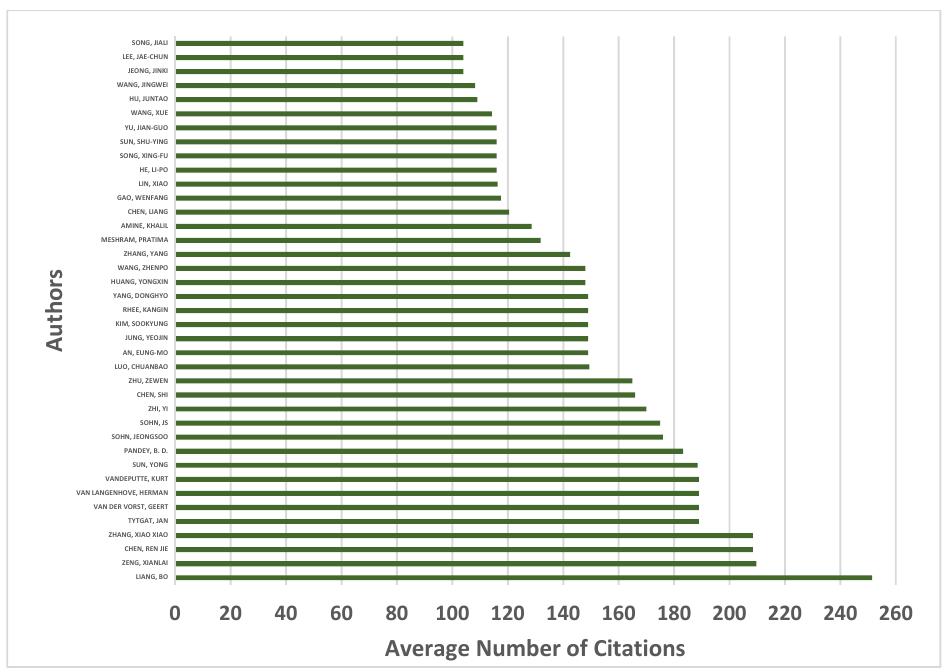
Figure 17. Authors with average citations greater than 100.